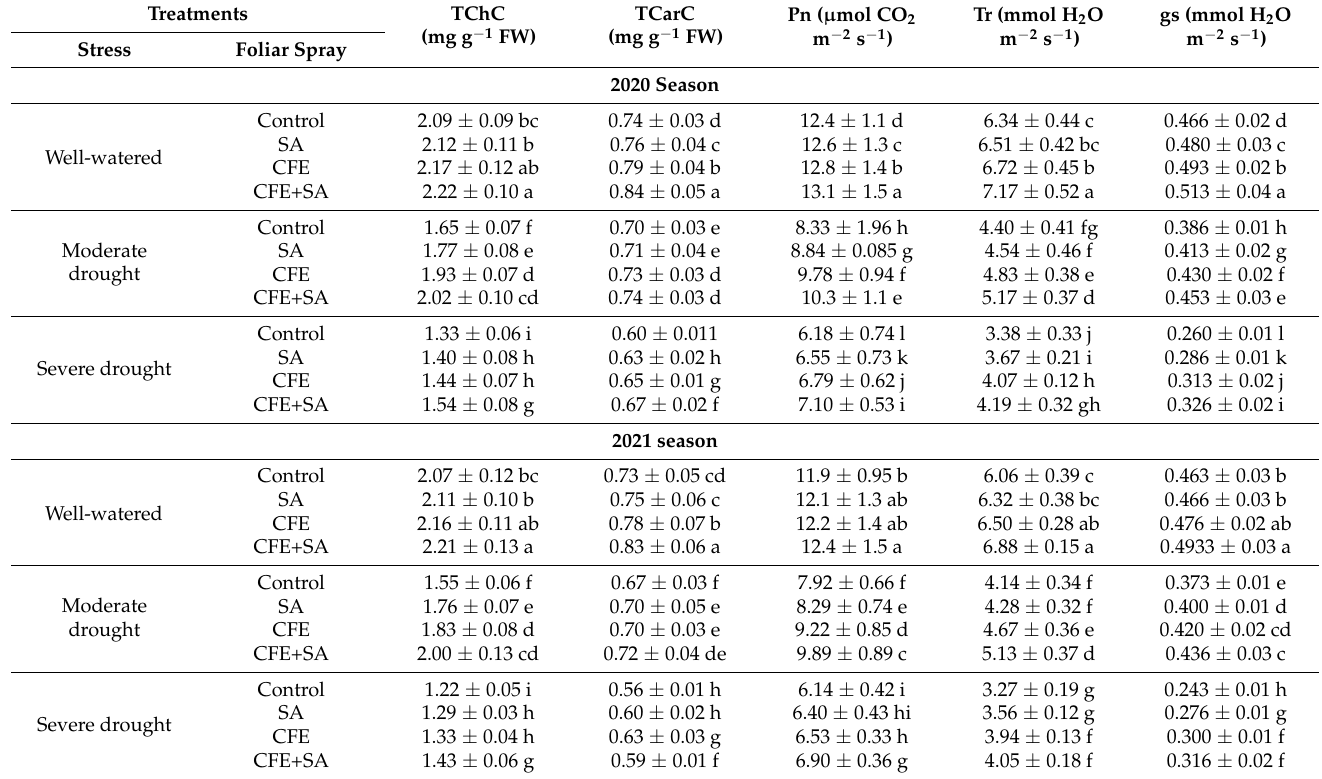
Table 4. Influence of foliar nourishment with clove fruit extract (CFE) and salicylic acid (SA) on total chlorophyll content (TChC), total carotenoid content (TCarC), net photosynthetic rate (Pn), stomatal conductance (gs), and transpiration rate (Tr) of potato plants grown under three irrigation regimes in two seasons.